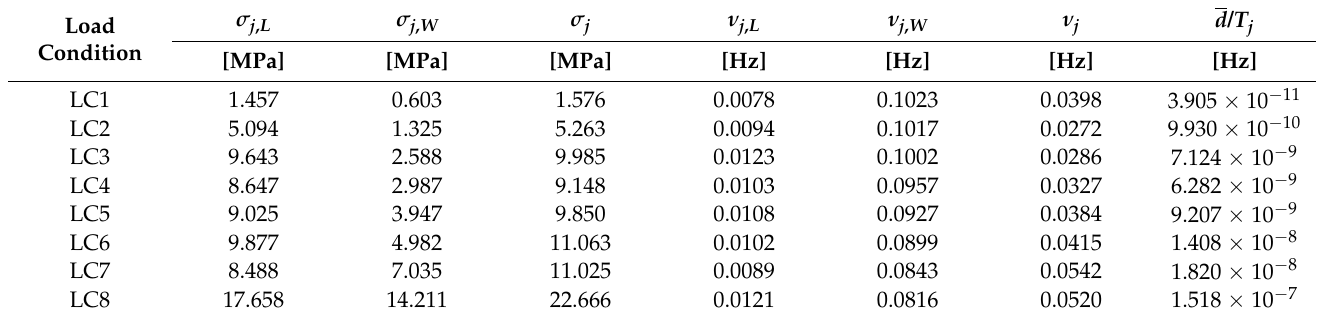
Table 6. Fatigue assessment by spectral analysis—Thomson